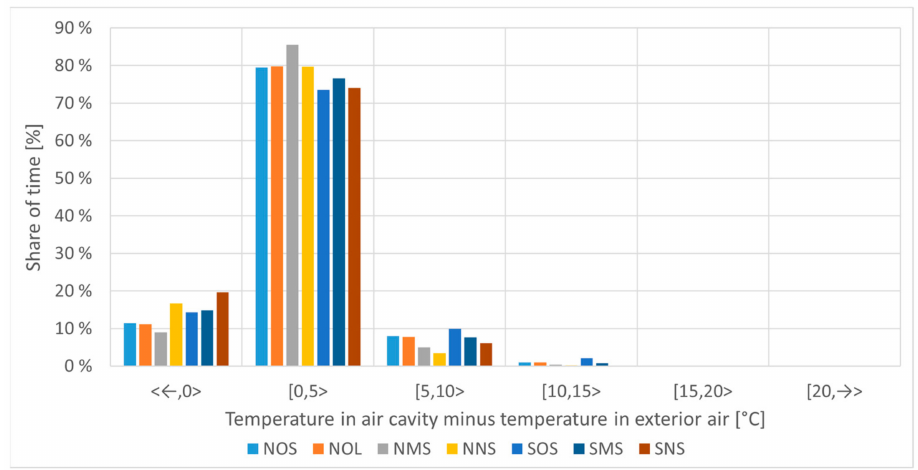
Figure 14. The difference between air cavity temperature and exterior temperature, T ext , for